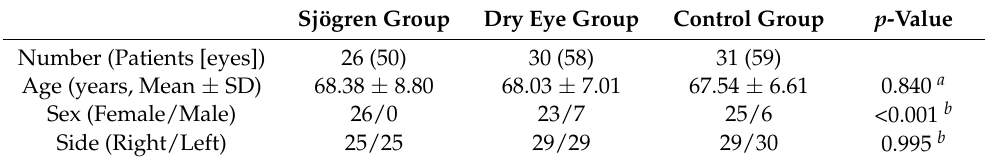
Table 1. Patients